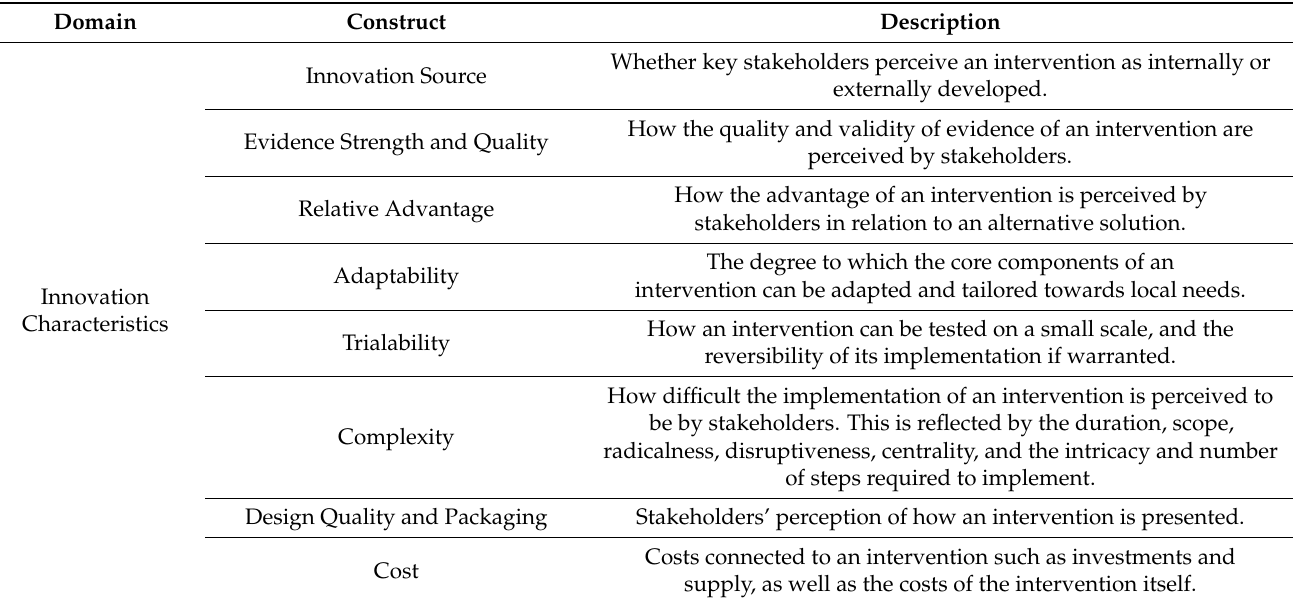
Table 2. The Consolidated Framework of Implementation Research (CFIR) with its domains, con- structs, and their